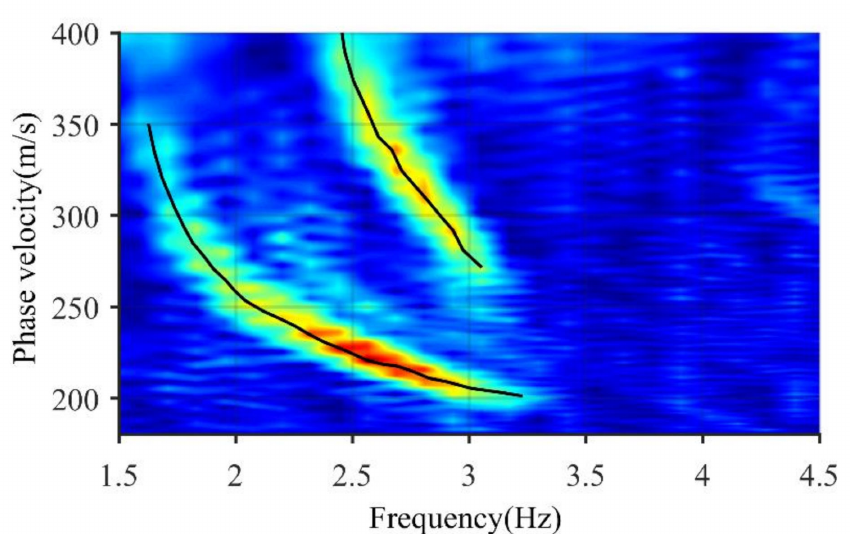
Figure 10. Scholte wave phase velocity dispersion diagram. The extracted fundamental mode and first higher-order mode dispersion data are represented by black